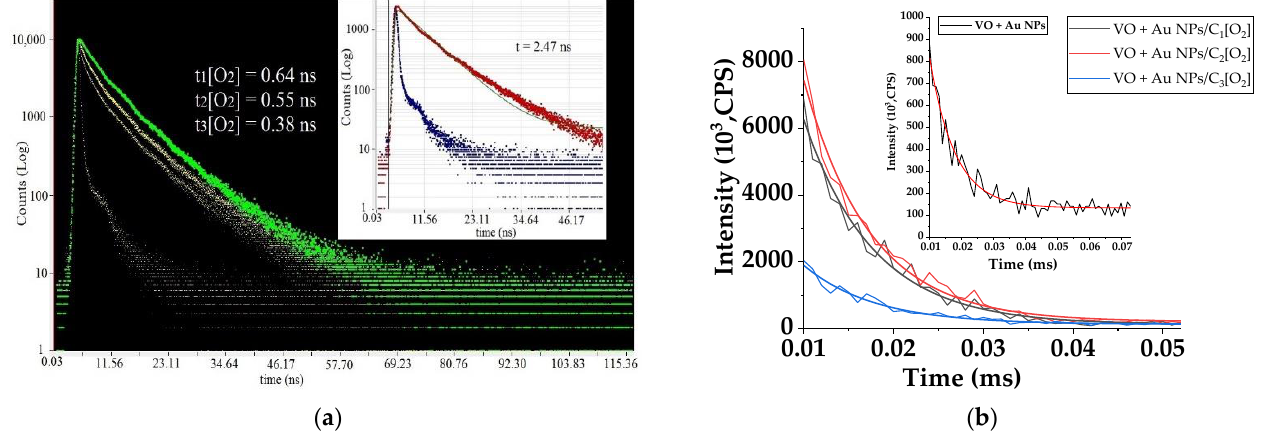
Figure 4. ( a ) Kinetic decay curves of the luminescence from the VO extract microemulsion with Au NPs (C = 10 − 10 M) at a wavelength of 420 nm under photoexcitation with wavelength of 400 nm at different oxygen concentrations (C 1 , C 2 , C 3 ), inset — without oxygen. ( b ) Kinetics decay of extract molecule triplet states with Au NPs with oxygen of different concentrations (C 1 , C 2 , C 3 ) registered at a wavelength of 680 nm with photoexcitation of 530 nm (triplet states), inset — without oxygen. C 1 = 2 × 10 − 4 M, C 2 = 3.5 × 10 − 4 M, C 3 = 8.5 × 10 − 4 M.